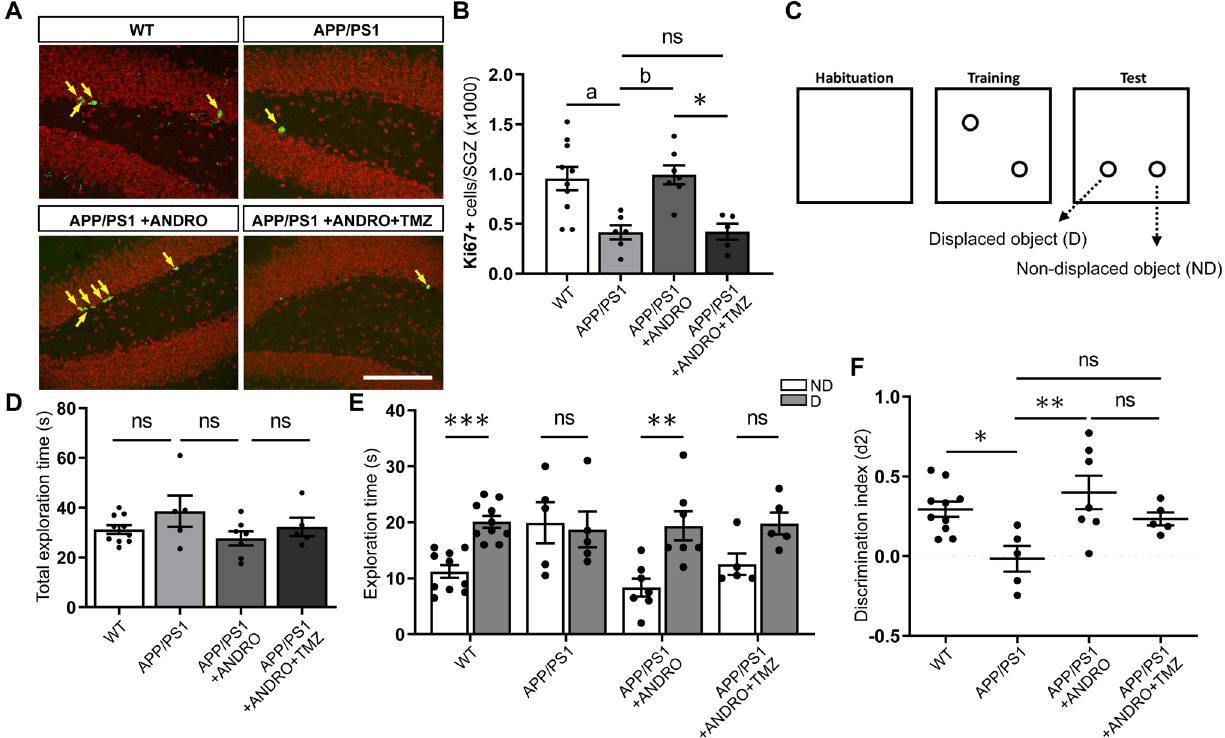
Figure 5. ANDRO improves spatial memory in APPswe/PSEN1ΔE9 mice. ( A ) Representative confocal images of the immunofluorescence of Ki67-positive (Ki67+, arrows) cells in the dentate gyrus of control wild-type (WT) mice, APPswe/PSEN1ΔE9 (APP/PS1) mice injected with vehicle, ANDRO or ANDRO + TMZ. Images correspond to maximal projection of 10 µm z-stack. Scale Bar: 50 µm. ( B ) Quantification of the total number of Ki67+ cells in the SGZ. One-way ANOVA test followed by Bonferroni post-hoc test. a p = 0.0185; b p = 0.0177; *p = 0.0139. ns, non-significant. ( C ) Schematic representation of the object location memory (OLM) test. ( D ) Quantification of the total exploration time in WT mice, APP/PS1 mice injected with vehicle, ANDRO or ANDRO + TMZ. ns, non-significant, One-way ANOVA test followed by Bonferroni post-hoc test. ( E ) Quantification of the time spent exploring the non-displaced (ND) and displaced (D) objects. ***p = 0.0002, **p = 0.0012, ns, non-significant. Mann–Whitney test. ( F ) Discrimination index (d2) calculated by dividing the difference of time spent to explore D and ND objects by the total time exploring both objects. *p = 0.0335, **p = 0.0067; ns, non-significantly different, one-way ANOVA test followed by Bonferroni post-hoc test. In ( B – F ), WT = 10 animals; APP/PS1 = 5 animals; APP/PS1 + ANDRO = 7 animals; APP/PS1 + ANDRO + TMZ = 5